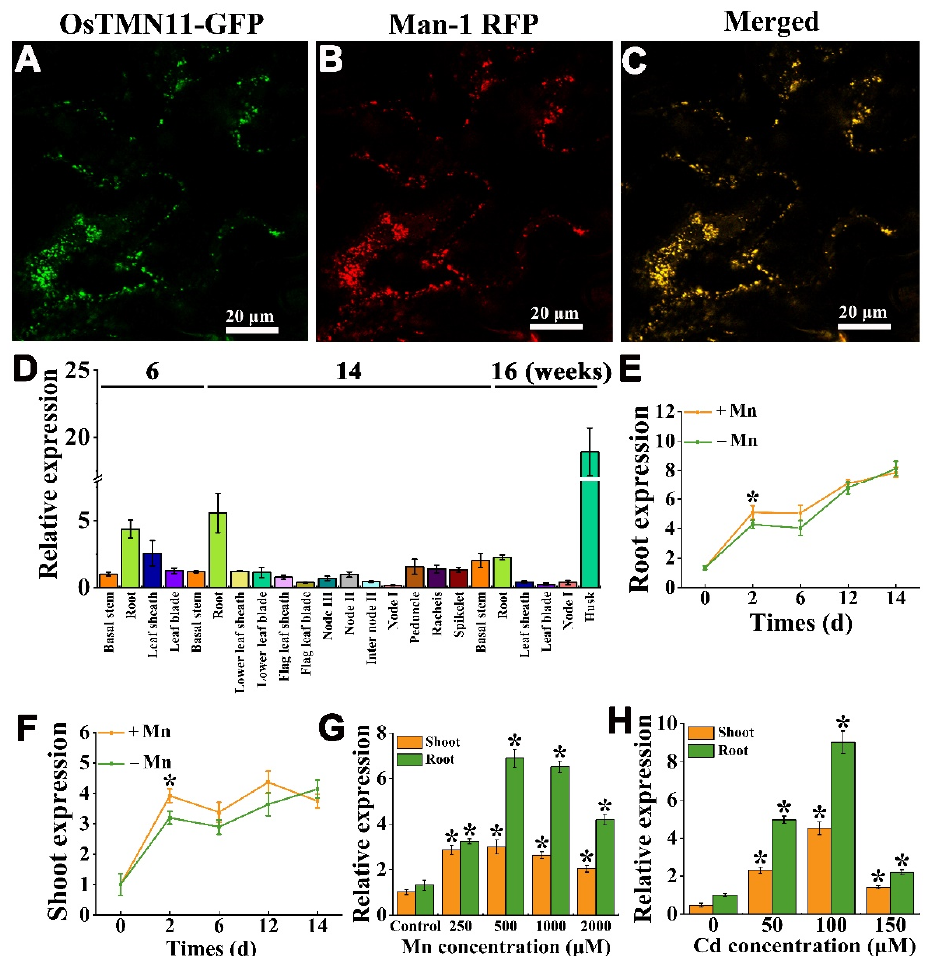
Figure 2. OsTMN11 subcellular localization and transcriptional expression patterns under normal conditions and Mn or Cd stress. ( A – C ) Subcellular localization of OsTMN11-GFP fusion protein in tobacco leaf epidermal cells detected by confocal laser scanning microscopy. ( A ) The GFP fluorescence signal of OsTMN11-GFP fusion protein only. ( B ) The red fluorescence of Golgi maker (Man-1). ( C ) The merged image of the OsTMN11-GFP fusion protein signal and the Golgi maker (Man-1 RFP for cis -Golgi). Bars = 20 μ m. ( D ) Transcriptional expression of OsTMN11 in different tissues or organs of rice grown at the vegetive, flowering, and developmental stages. ( E – G ) Two week-old rice seedlings were exposed to excessive Mn for three hours ( E ), deficient Mn for two weeks ( F , G ), or excessive Cd for three hours ( H ). Error bars indicate the means ± standard deviations of three biological replicates. Asterisks indicate that the mean values are significantly different between the treatment and control ( p < 0.05).